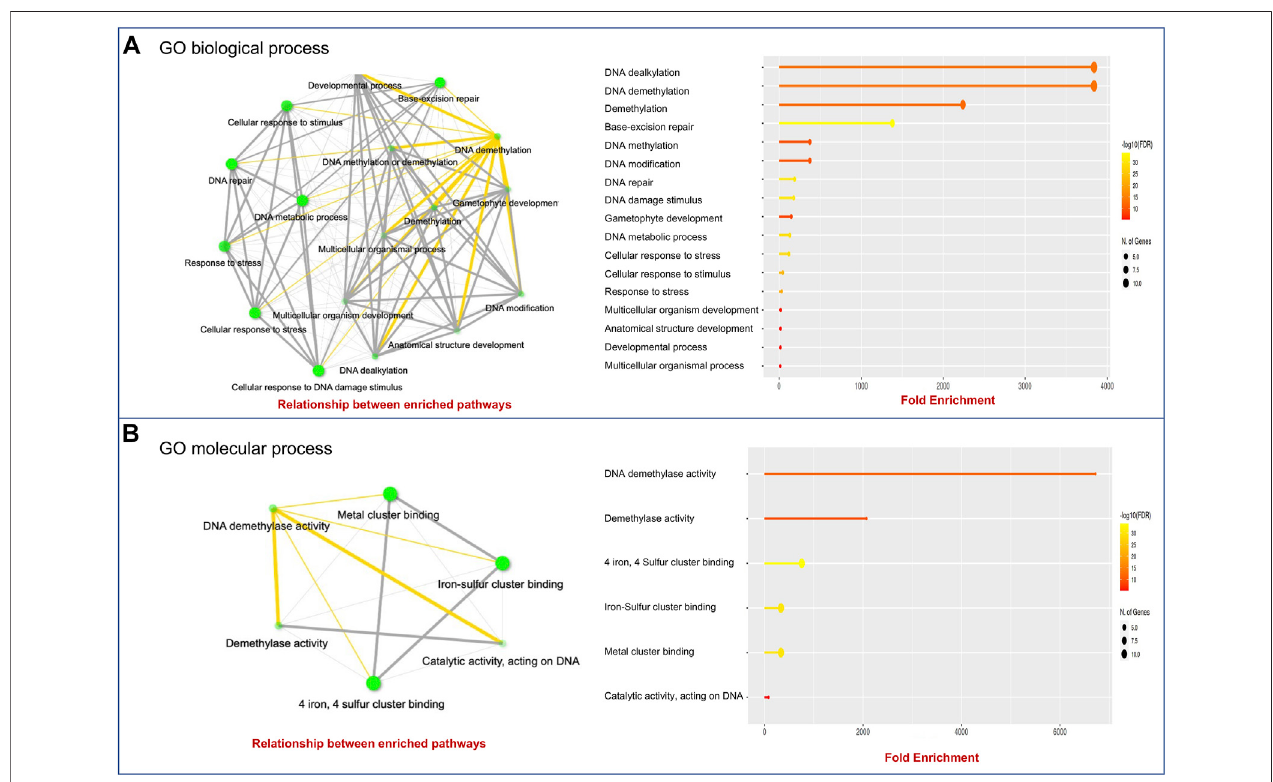
FIGURE 5 | GO analysis using ShinyGo identi fi ed enriched biological processes (A) and molecular processes (B) of dMTase genes. The green dots represent the nodes for each GO biological process or molecular process, while the lines (yellow and grey) represent the interaction between the nodes (minimum of 20% genes common between two connected) GO